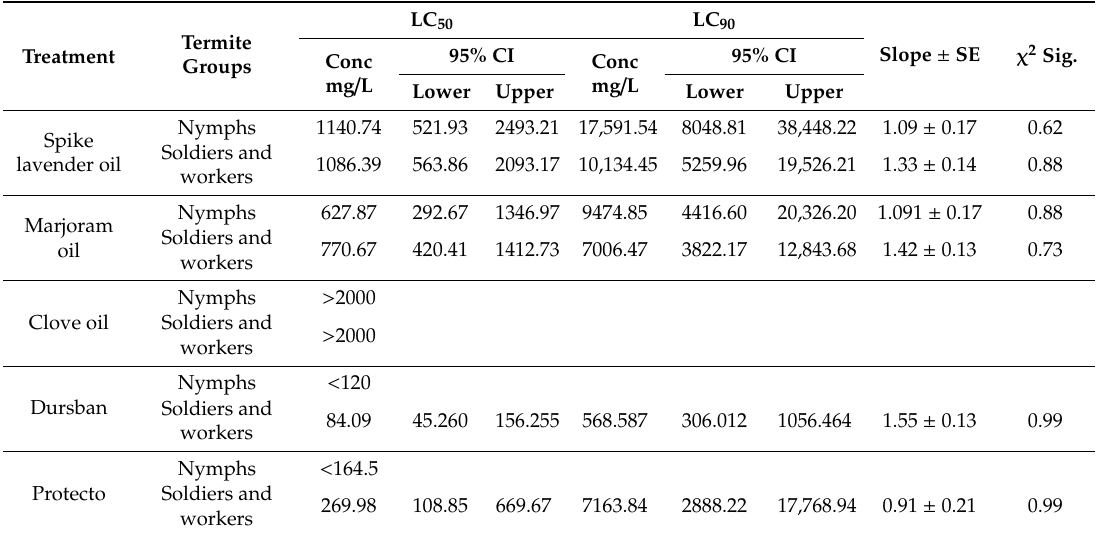
Table 4. The insecticidal activity of three plant extracts, Dursban, and Protecto against termite groups.